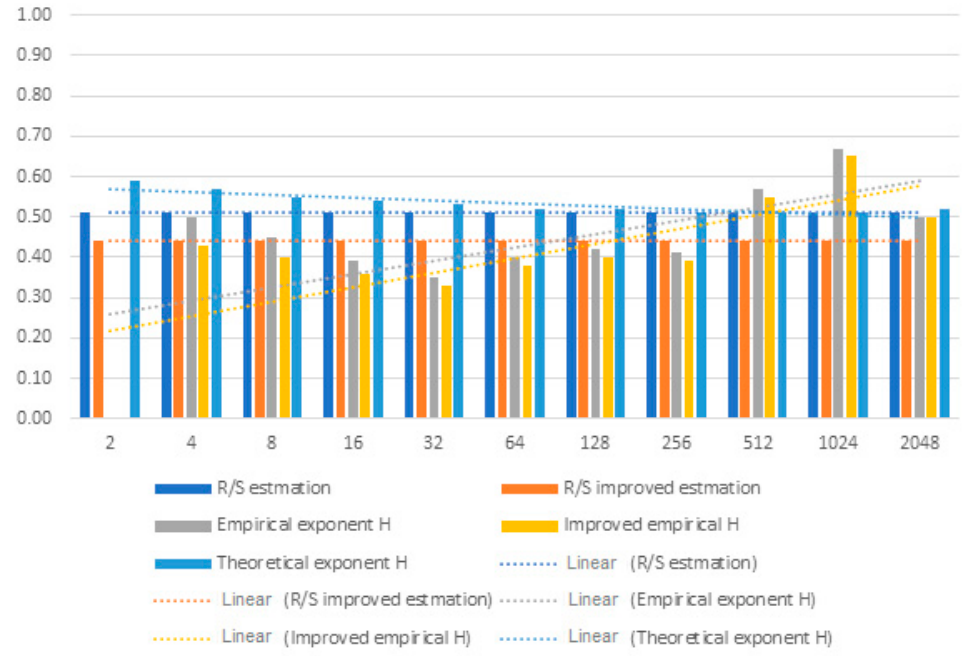
Table 4. Statistical analysis for general network traffic.